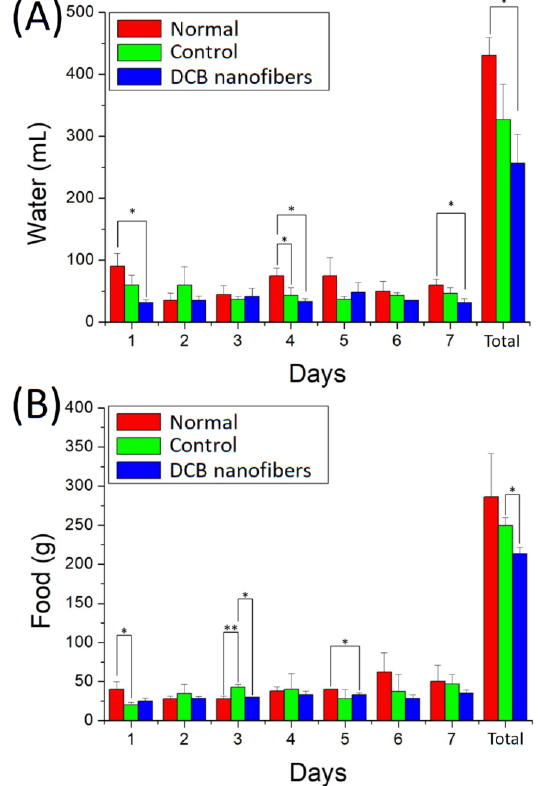
Figure 8. ( A ) Water, and ( B ) food intakes for the rats in various groups (* p < 0.05, ** p < 0.01).